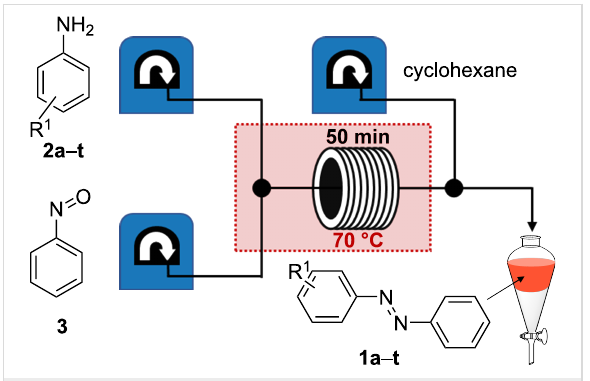
Figure 3: Flow setup after prior optimization with unsubstituted aniline ( 2a ) and nitrosobenzene ( 3 ) to AB ( 1a